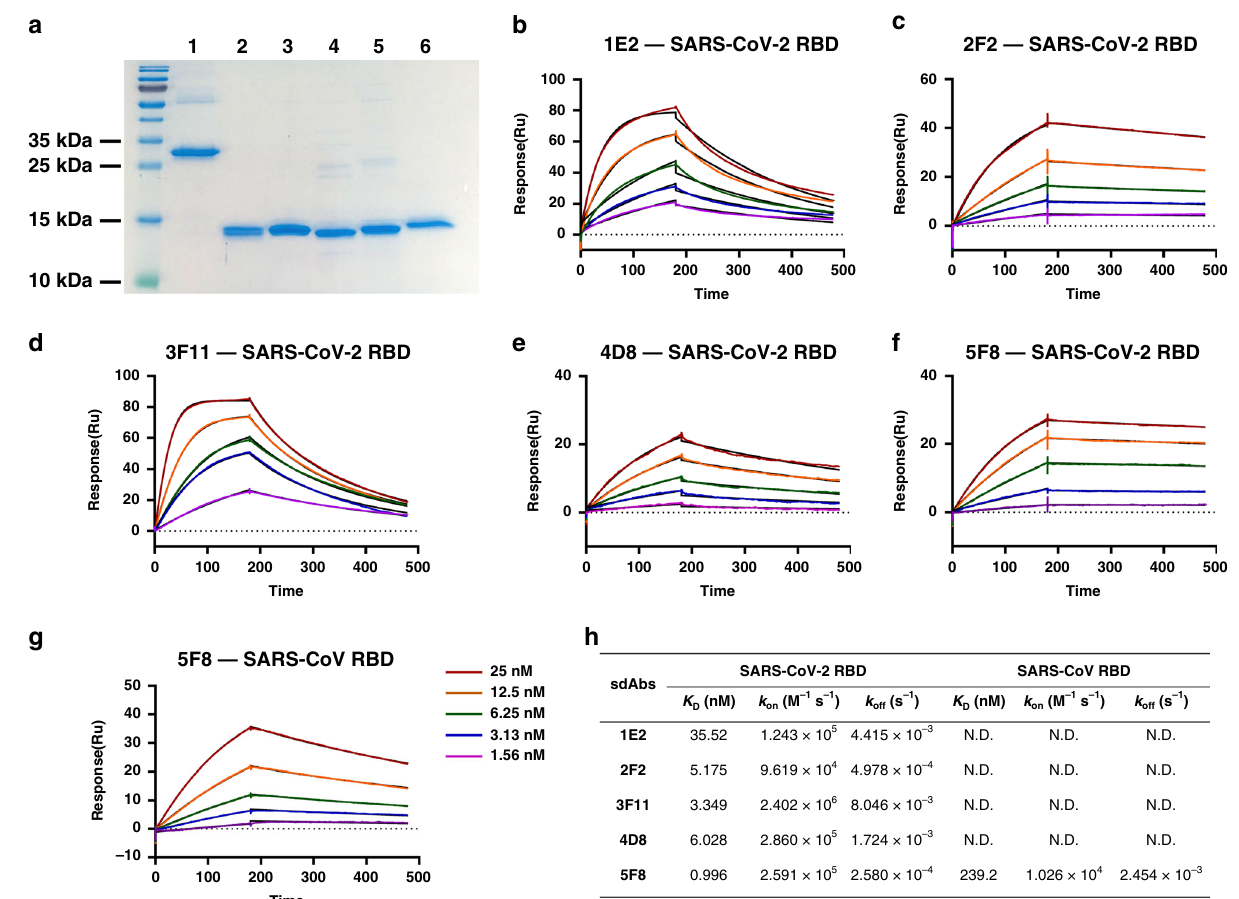
Fig. 1 Identi fi cation of SARS-CoV-2 RBD binding sdAbs. a The puri fi ed recombinant proteins of SARS-CoV-2 RBD and sdAbs were separated by SDS- PAGE and stained with Coomassie Blue. Lanes: 1, SARS-CoV-2 RBD; 2, 1E2; 3, 2F2; 4, 3F11; 5, 4D8; 6, 5F8. b – f Five sdAbs binding to SARS-CoV-2 RBD measured by SPR. Two-fold serial dilutions from 25 nM sdAb injected onto the captured RBD protein. Kinetic data from one representative experiment were fi t to a 1:1 binding model. The pro fi les are shown for 1E2 ( b ), 2F2 ( c ), 3F11 ( d ), 4D8 ( e ), and 5F8 ( f ). g Kinetics of binding between SARS-CoV RBD and sdAb 5F8. h Summary of SPR kinetic and af fi nity measurements. The equilibrium dissociation constant ( K D ), the association constant ( k on ) and the dissociation constant ( k off ) are presented. N.D. means not